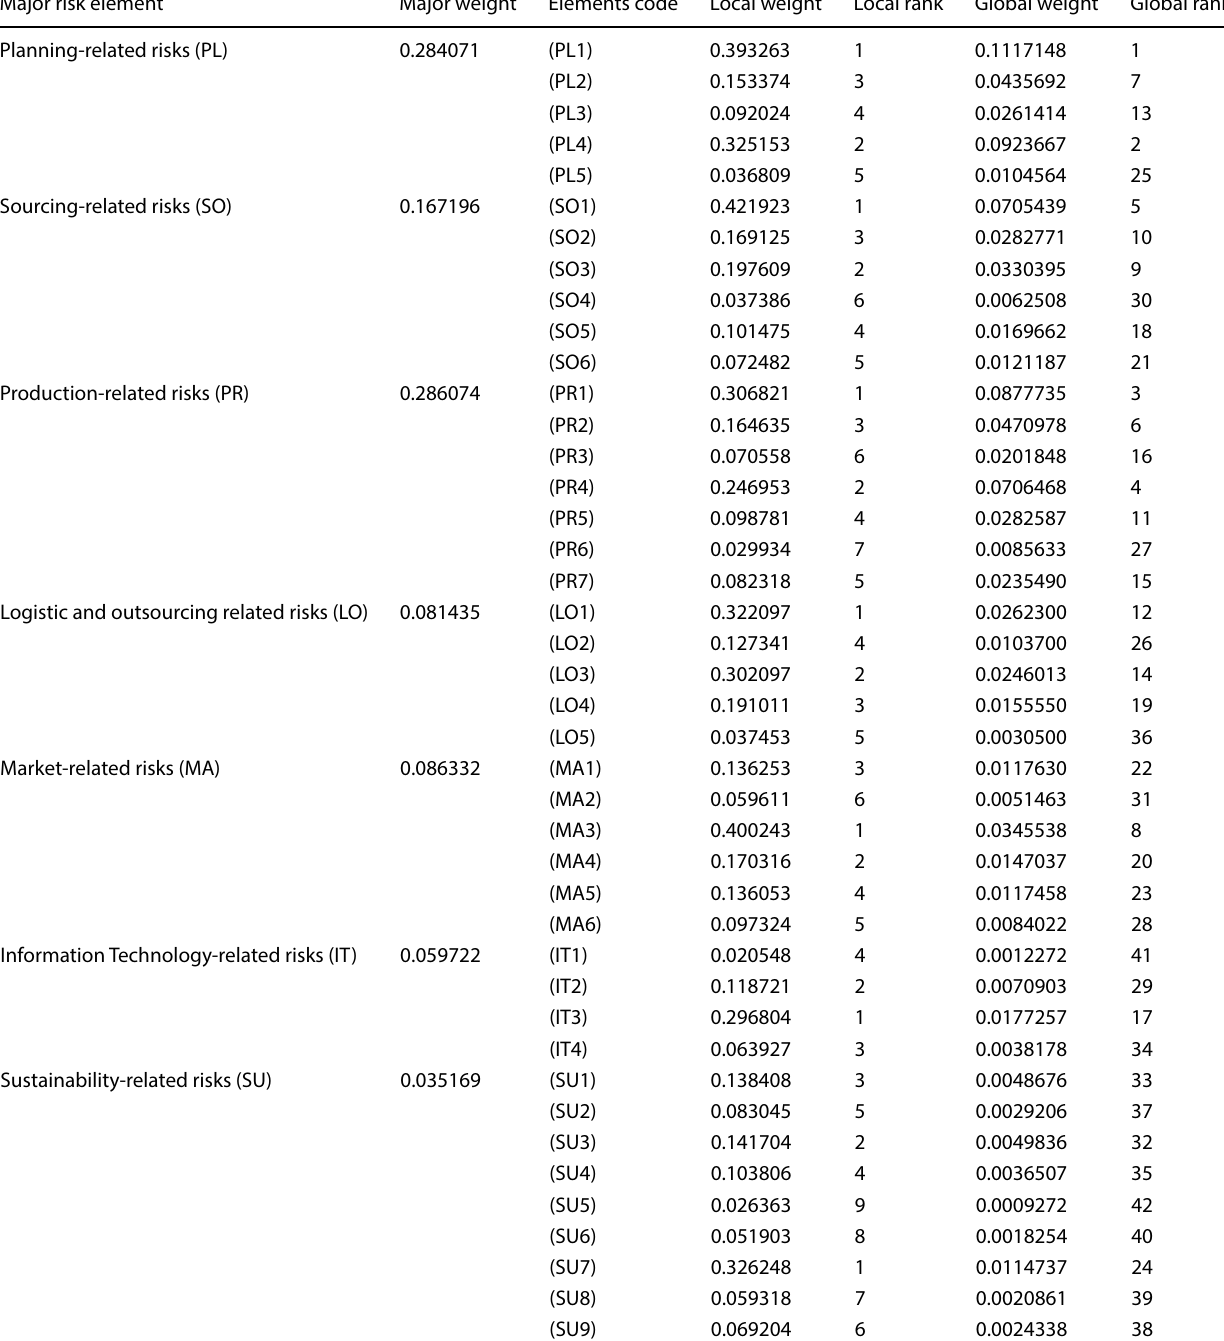
Table 5 Final ranking of major risk and risk elements of HSC Major risk